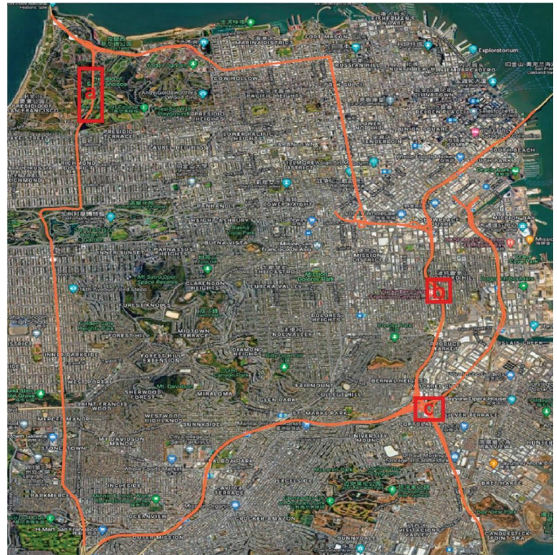
Figure 15: Lane-level road map generation results based on the proposed